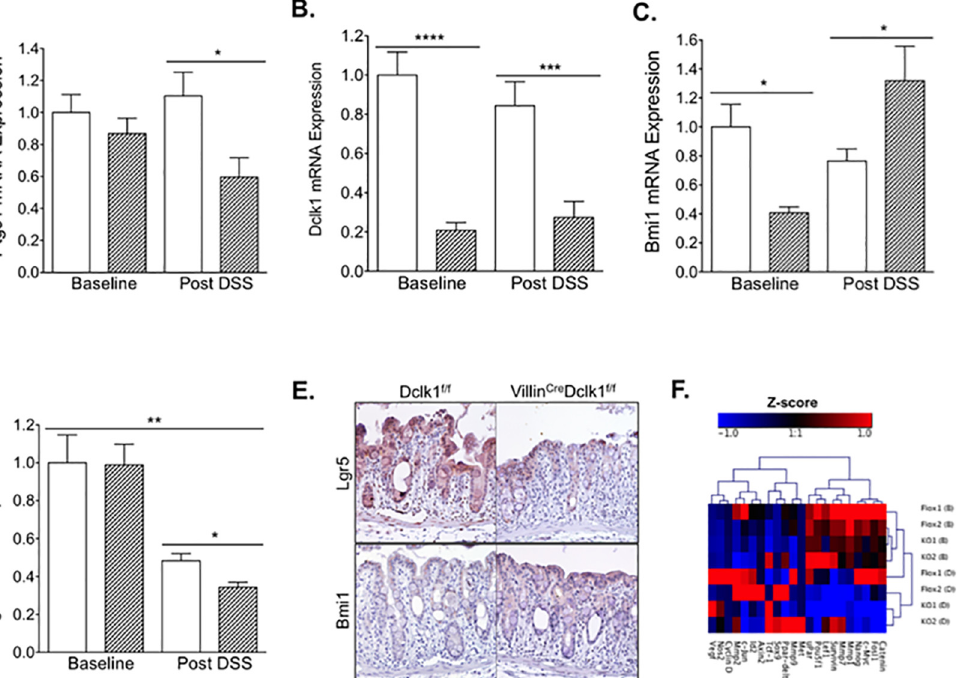
Fig 8. Deletion of epithelial Dclk1 alters the intestinal tuft and stem cell signature. Total RNAs were isolated from colonic tissue. The mRNA expression levels of Dclk1, Ptgs1, Lgr5, and Bmi1 ( A, B, C, D ) were measured by quantitative real-time RT-PCR, and normalized against β -actin (dashed bar = Villin Cre ; Dclk1 f/f , open bar = Dclk1 f/f ). Values in the bar graphs are given as mean ± SEM and * , ** , *** , **** denote statistically significant differences ( p < 0.05, < 0.005, < 0.0005, 0.00005 respectively). E . Colonic tissues were stained with anti-Lgr5 and anti-Bmi1 antibodies (Brown) post DSS treatment. F . The expression levels of mouse Wnt/b-Catenin regulated genes in colonic tissues were determined using Mouse Wnt/b-Catenin Regulated cDNA Plate